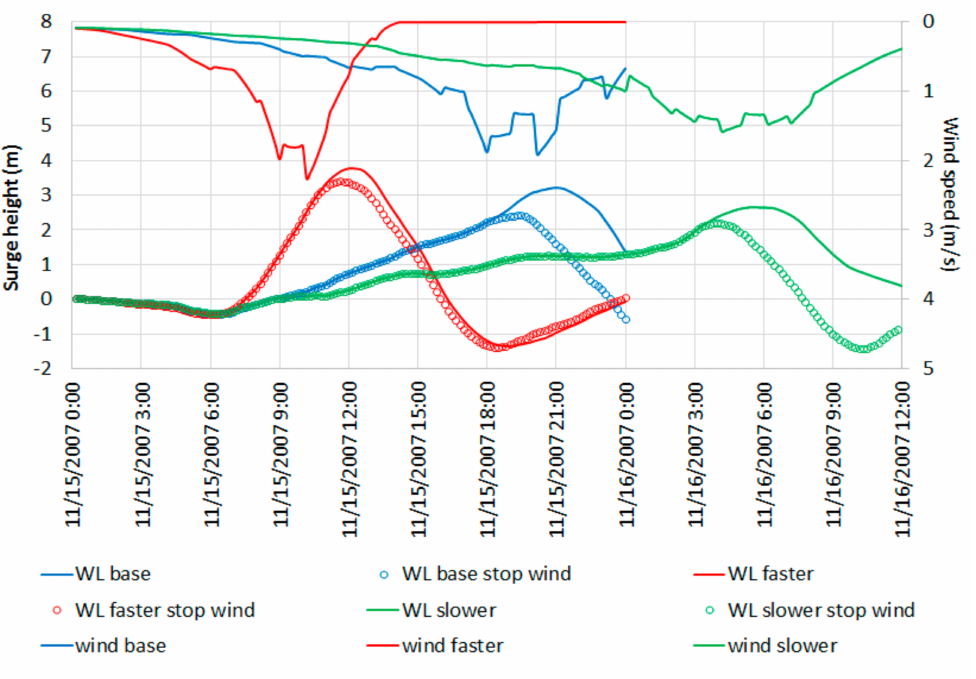
Figure 8. Computed wind speed and surge water levels for “faster”, “base” and “slower” cases at Chittagong. Firm lines represent wind speeds and surge heights and open circles represent surge height when wind is artificially removed after landfall. Red lines and circles correspond to “faster” cases, blue lines and circles correspond to “base” cases and green lines and circles correspond to “slower”